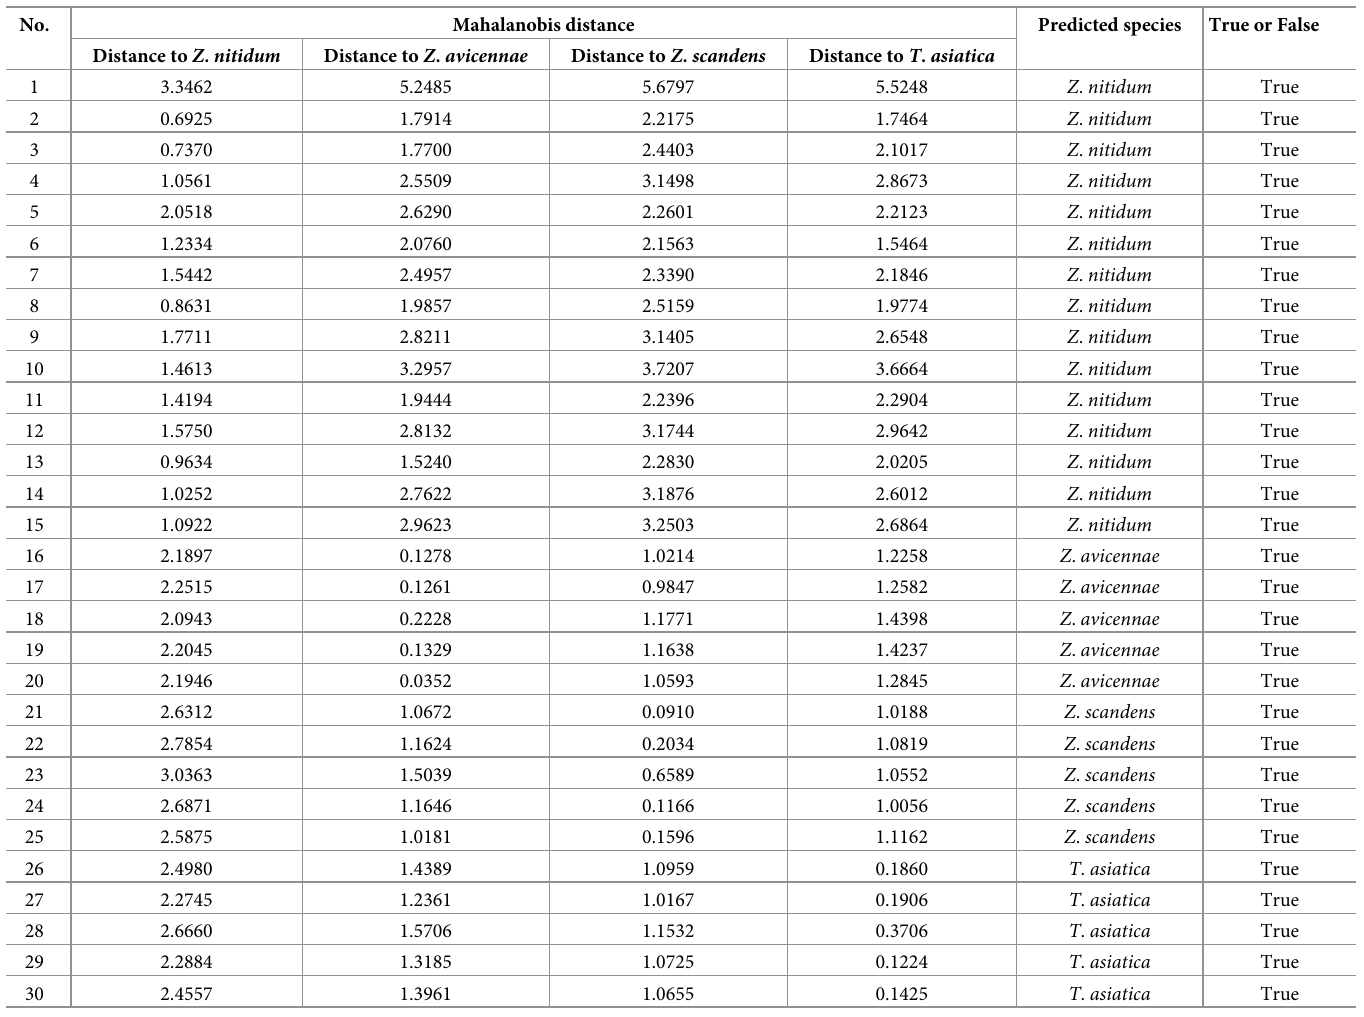
Table 2. Validation of the results of mahalanobis distance in the false identification model.